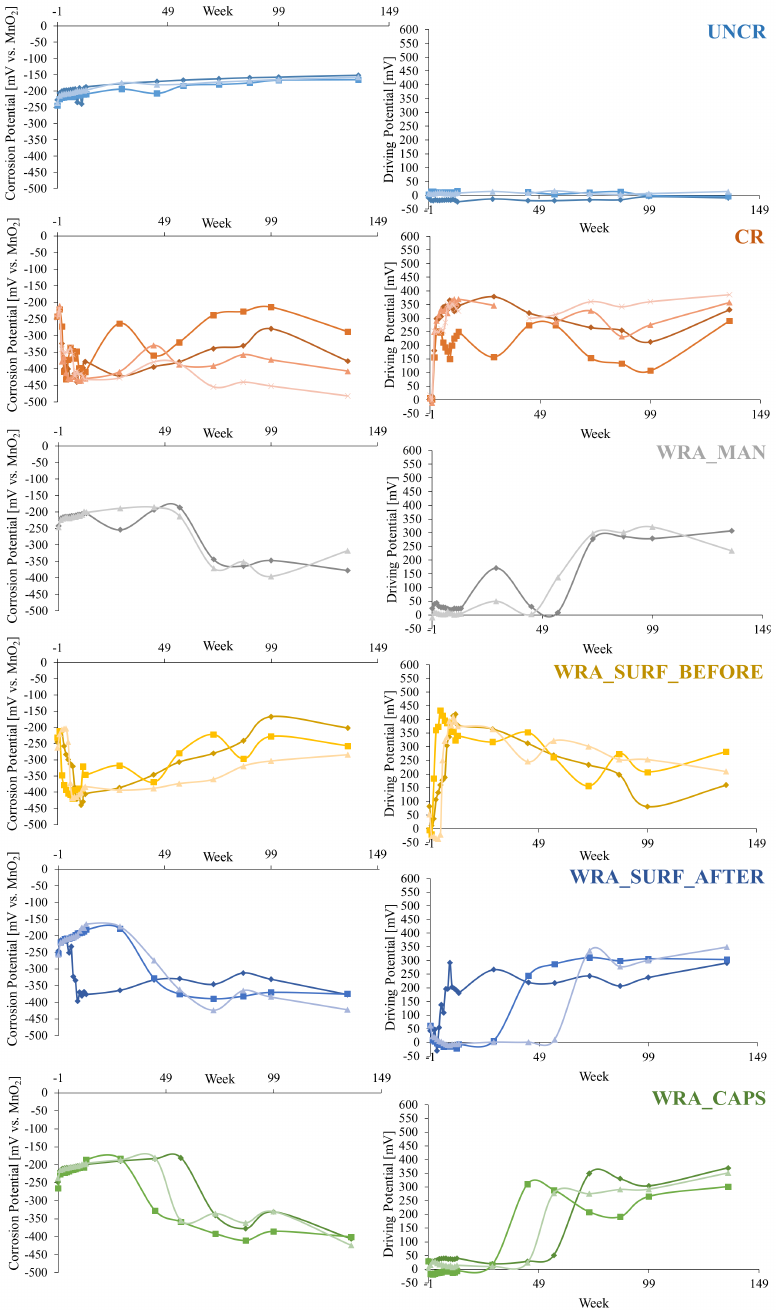
Figure 8. Evolution of the corrosion potential and driving potential over time (result for one sample of the WRA_MAN series is missing as the internal electrical connection with the anode was damaged during concrete casting, different shades of the colours are used to represent the repetitions per test